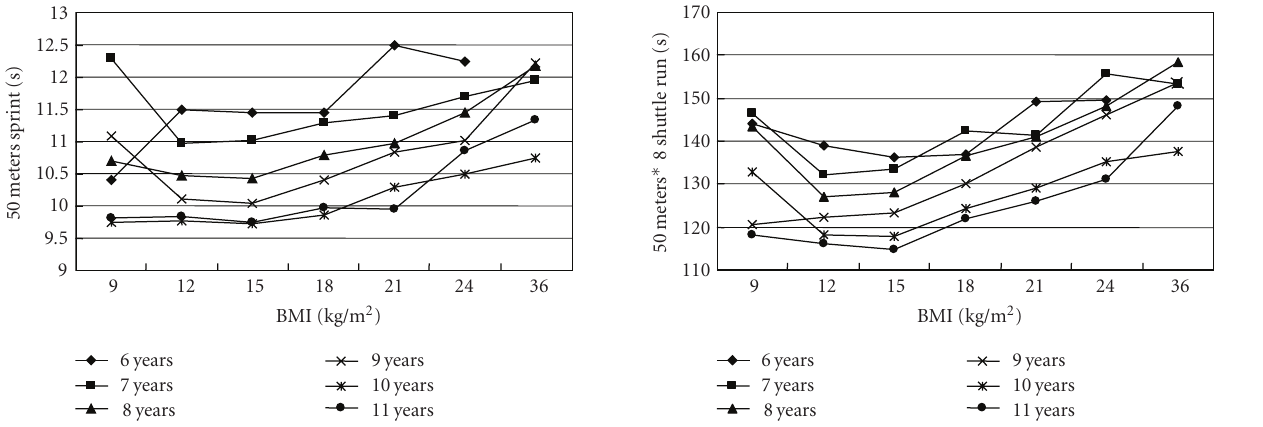
Figure 3: The association of 50 m ∗ 8 shuttle run time (s) with BMI (kg/m 2 ) in 4771 Chinese children aged 6–11